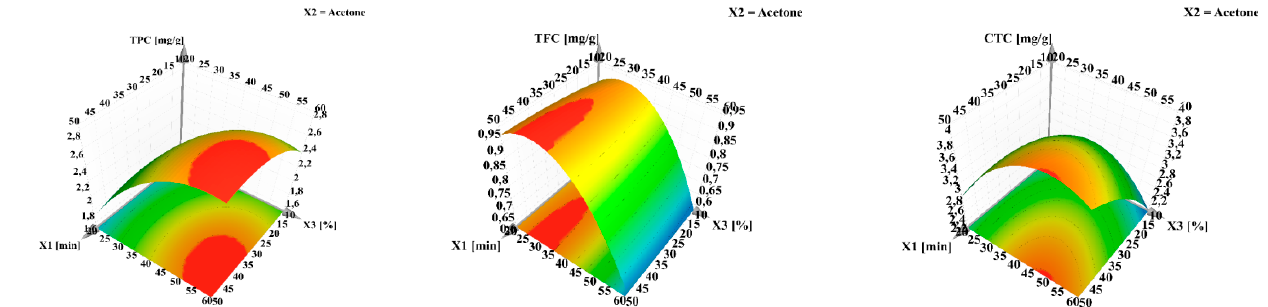
Figure 4. Response surface for predicting the recovery yield for total phenolic content (TPC), total flavonoid content (TFC) and condensed tannin content (CTC) from walnut flower extracts. X 1 —extraction time (min); X 2 —aolvent (cetone); X 3 —water in solvent (%, v/v ). The regions in red represent the domains of working conditions assuring the maximum extraction yield for the evaluated bioactive compounds.